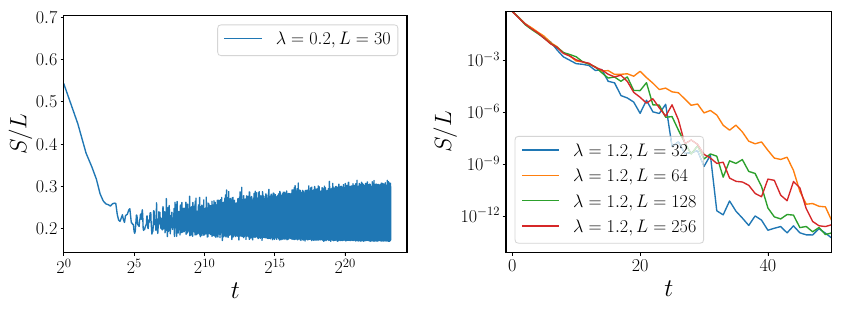
FIG. 10. Time evolution of entropy density for the nonunitary circuit